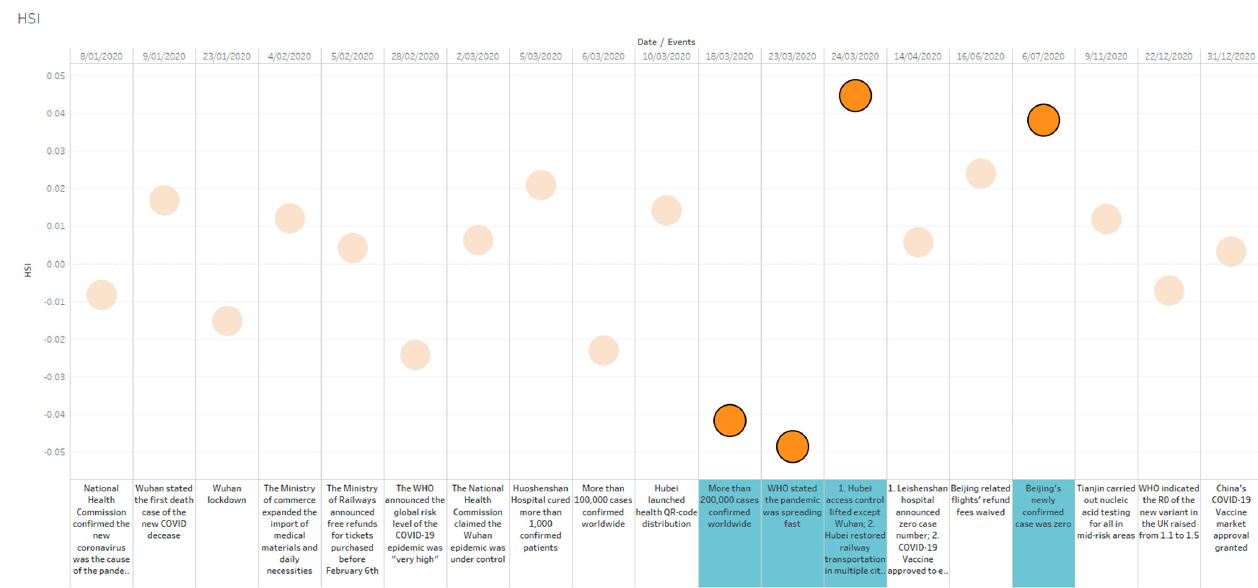
Appl. Sci. 2021 , 11 , x FOR PEER REVIEW Figure 3. HSI’s trends on relevant social events. Figure 3. HSI’s trends on relevant social events.